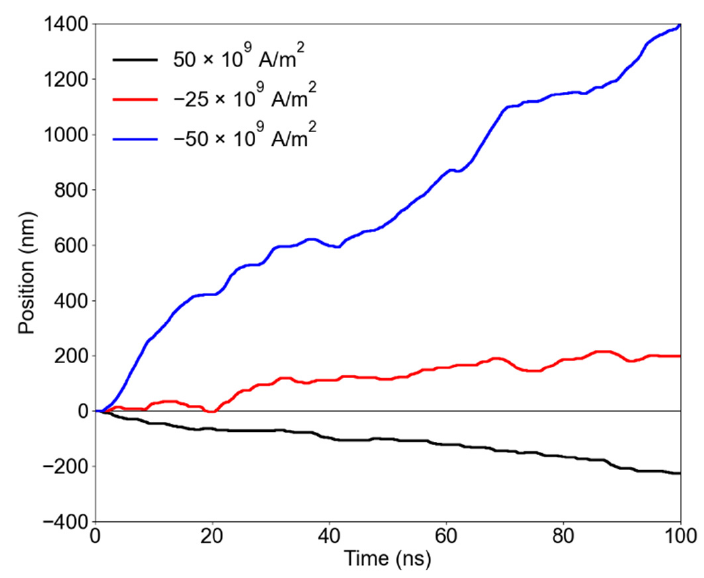
Figure 6. Domain wall displacement as a function of time with a temperature of 300 K. Variations of the domain wall velocity are due to thermal fluctuations of the domain wall structure. Data are shown for M Y = 1 .